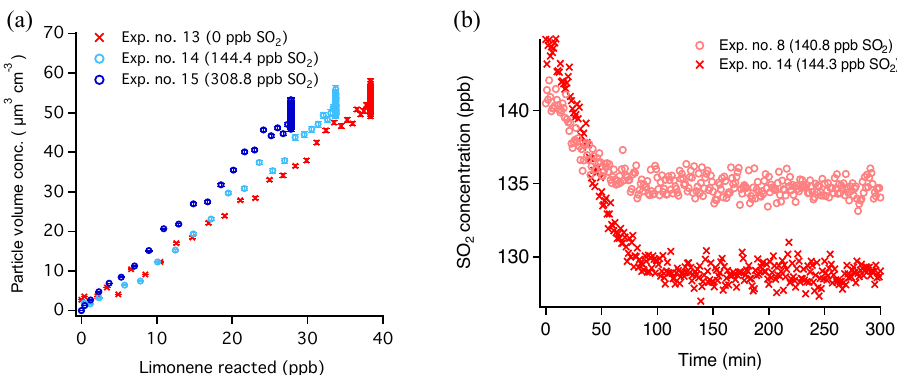
Figure 3. (a) Particle volume concentration as a function of limonene reacted under humid conditions. Enhanced particle mass formation was observed with increasing SO 2 concentration. (b) Greater consumption of SO 2 was observed under humid conditions than under dry conditions. By comparing Exp. #14 (humid) and Exp. #8 (dry), with similar initial SO 2 concentration, SO 2 consumption was more than two times greater under humid conditions.